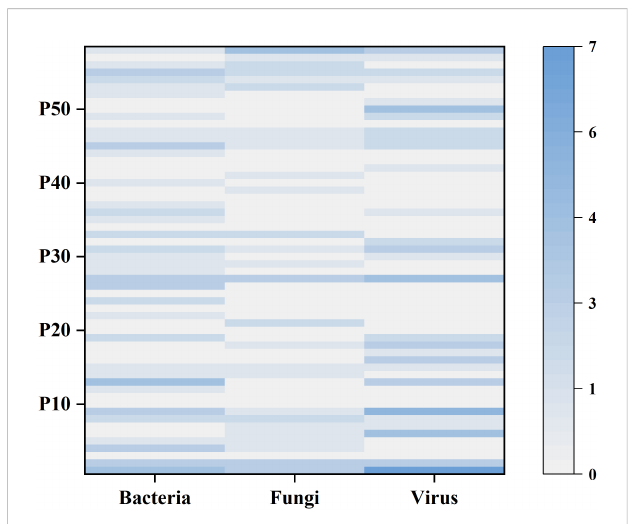
FIGURE 4 The heatmap shows the number of bacteria, fungi and viruses detected by mNGS in each sample. The left y-axis indicates the number of the 58 patients. The shade of color represents the number of microorganisms detected, with larger counts associated with darker colors.